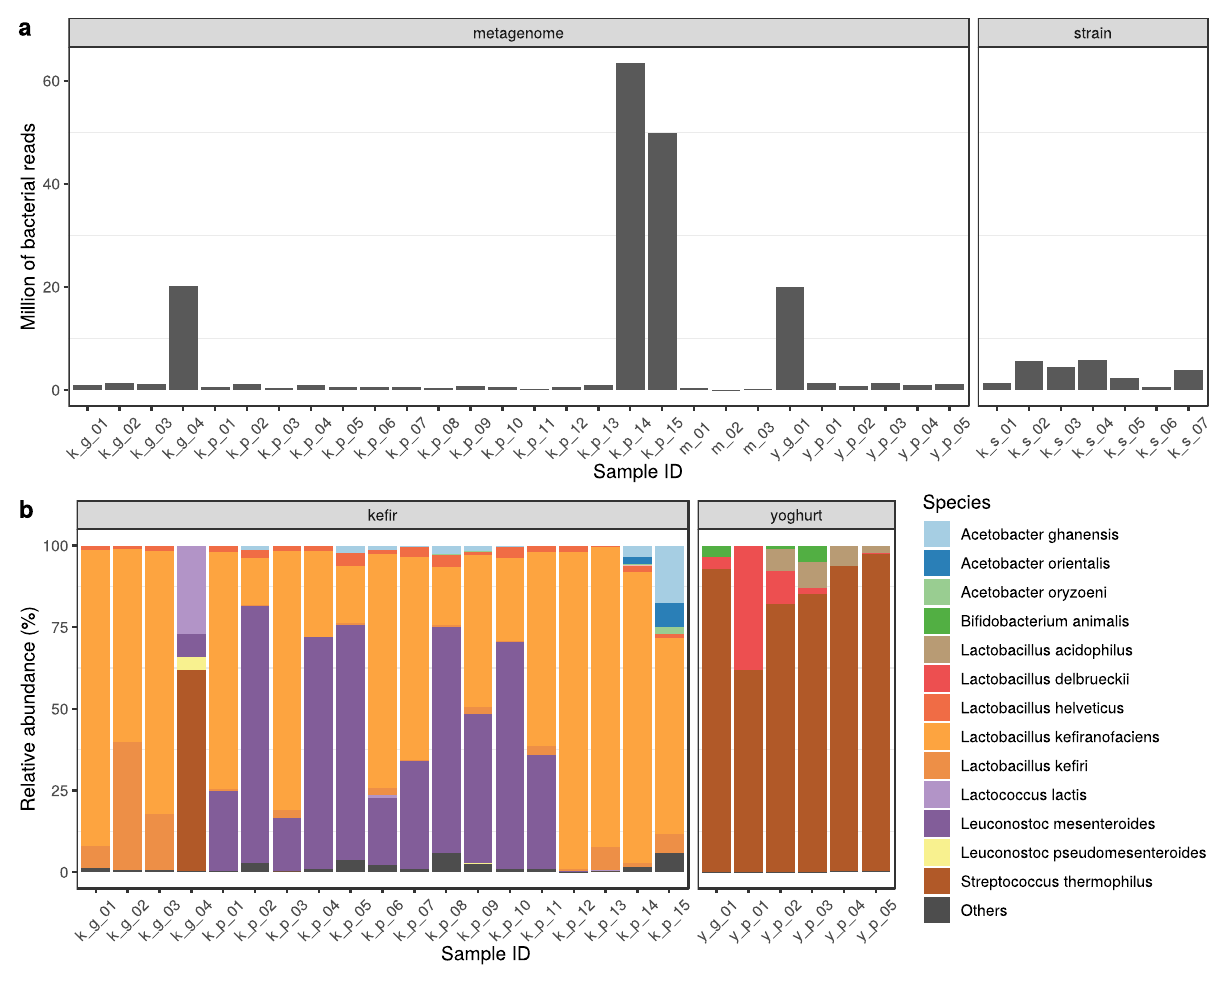
Figure 1. Bacterial content of the samples. ( a ) The number of reads classified bacterial by Kraken2 on the NCBI NT database. Metagenome includes the samples deriving from grains, milk or products. ( b ) Relative abundances of the most common bacterial species in the grain and product